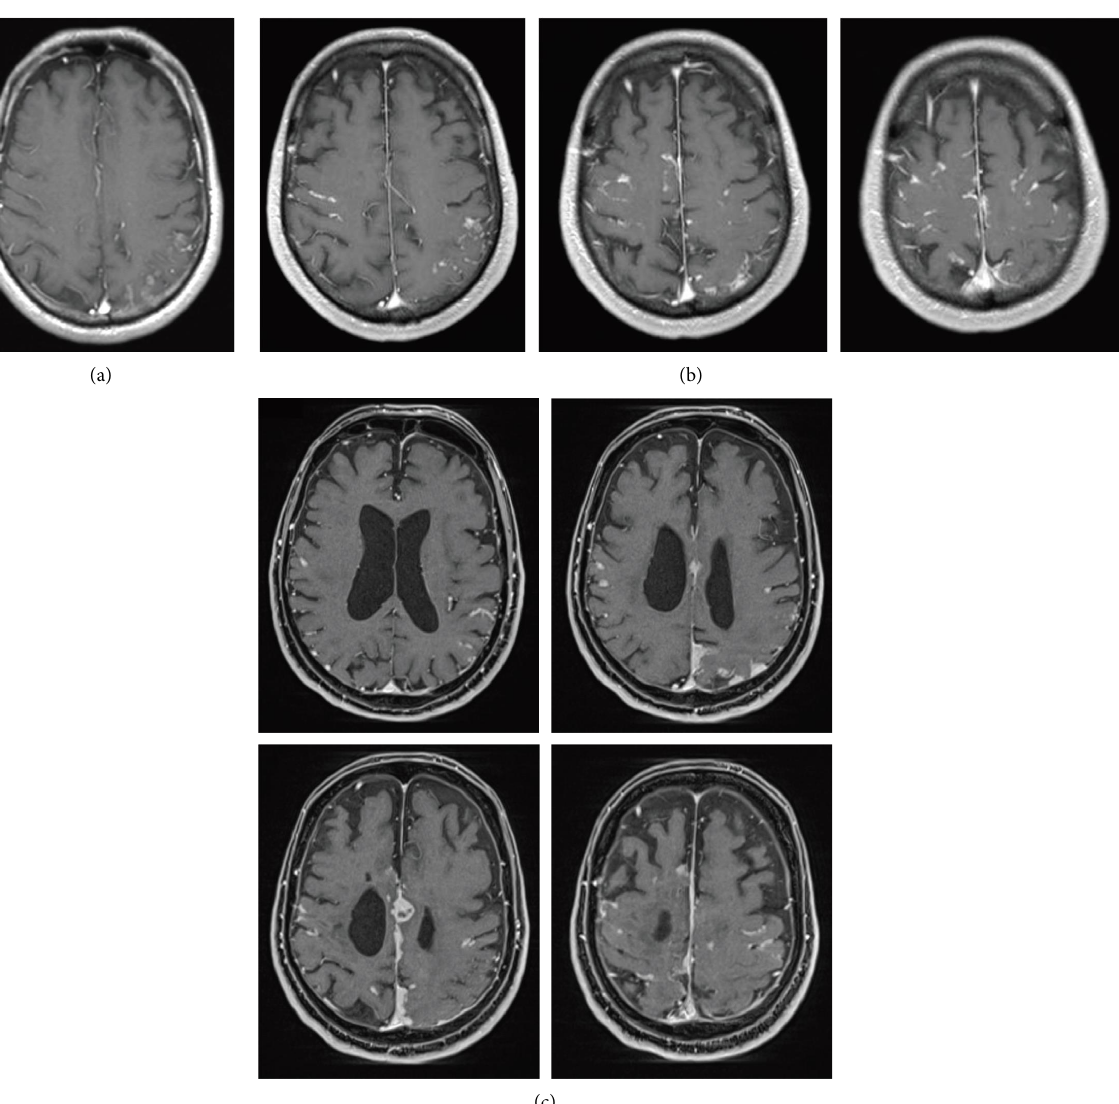
Figure 1: Axial T1 (longitudinal relaxation time) magnetic resonance imaging of the brain with contrast in (a) January 2008, (b) April 2010, and (c) January 2020, showing progression of multiple heterogeneously enhancing dural base and leptomeningeal